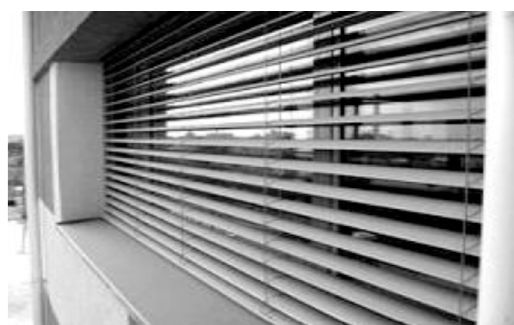
Fig. 5. The roof ’ s framework during